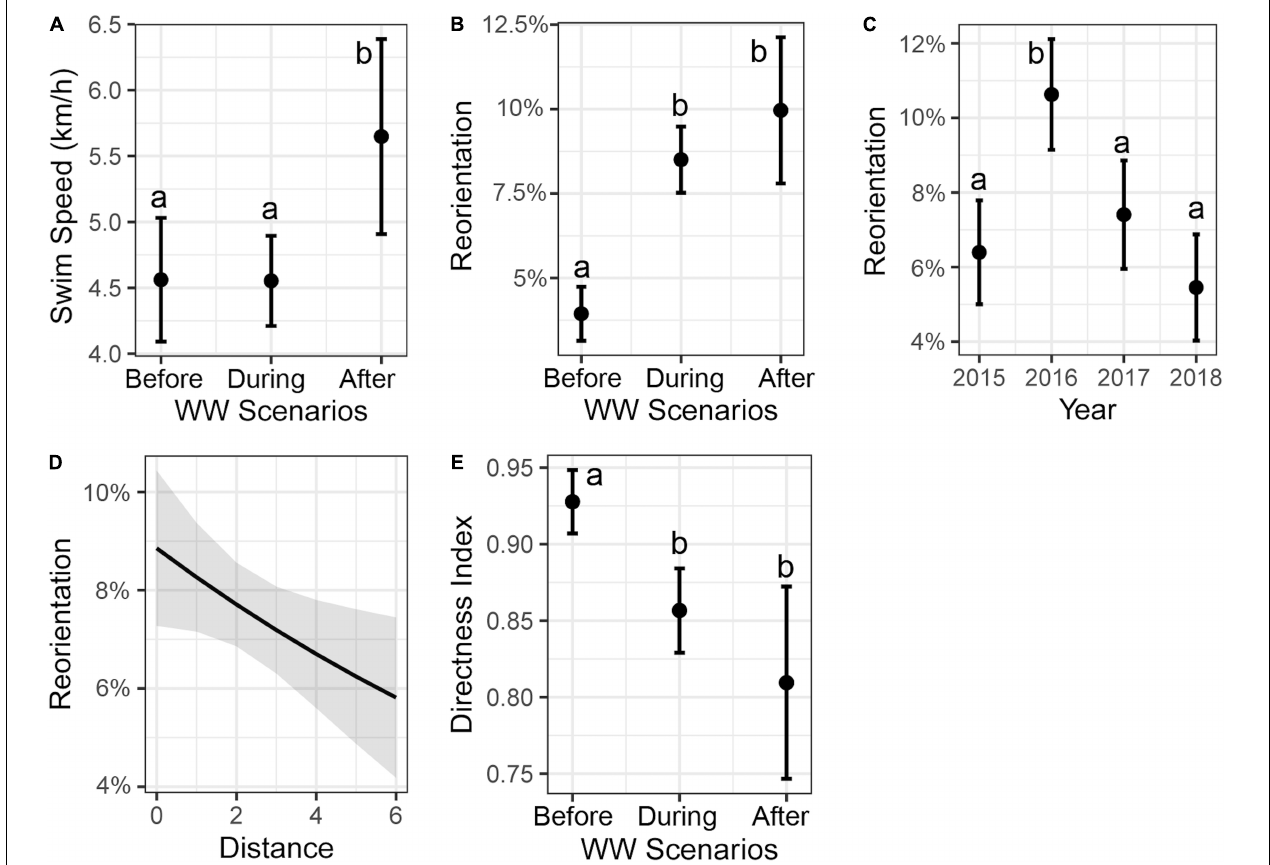
FIGURE 2 | Marginal effects (mean ± 95% confidence interval) from predictors of the best model for (A) swim speed, (B–D) reorientation, and (E) directness index during traveling behavior of fin whales. Different letters indicate significant differences between groups (Tukey post hoc ; P <